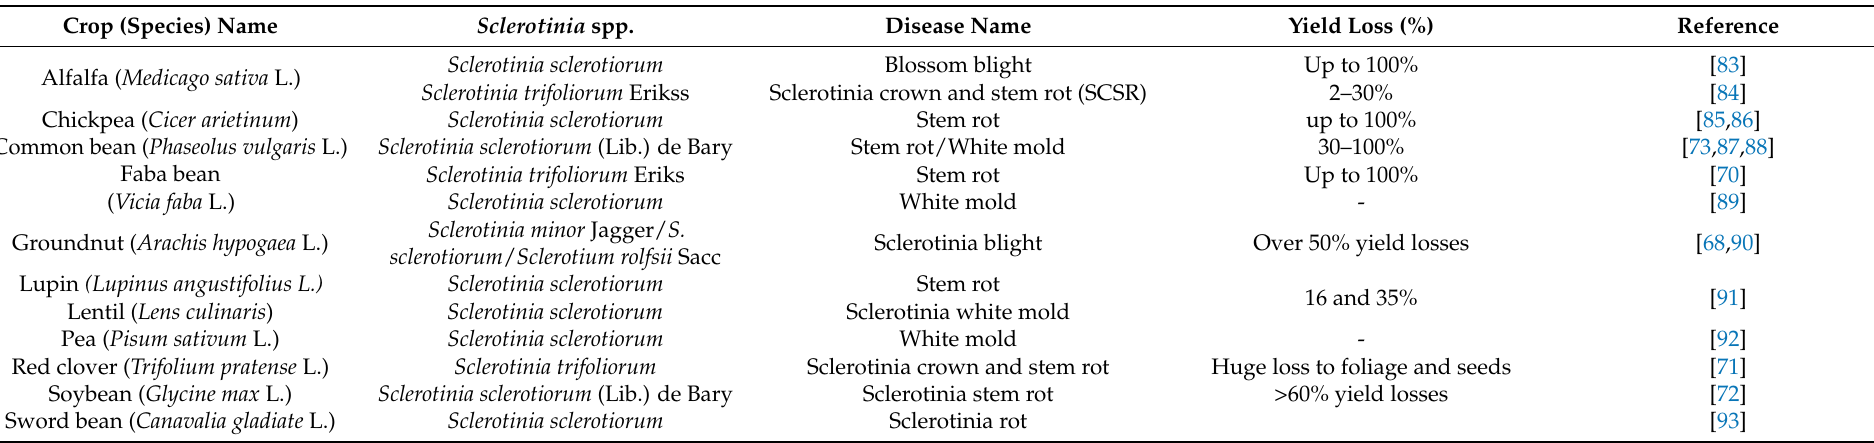
Table 1. Sclerotinia spp. disease cause and yield losses estimated in